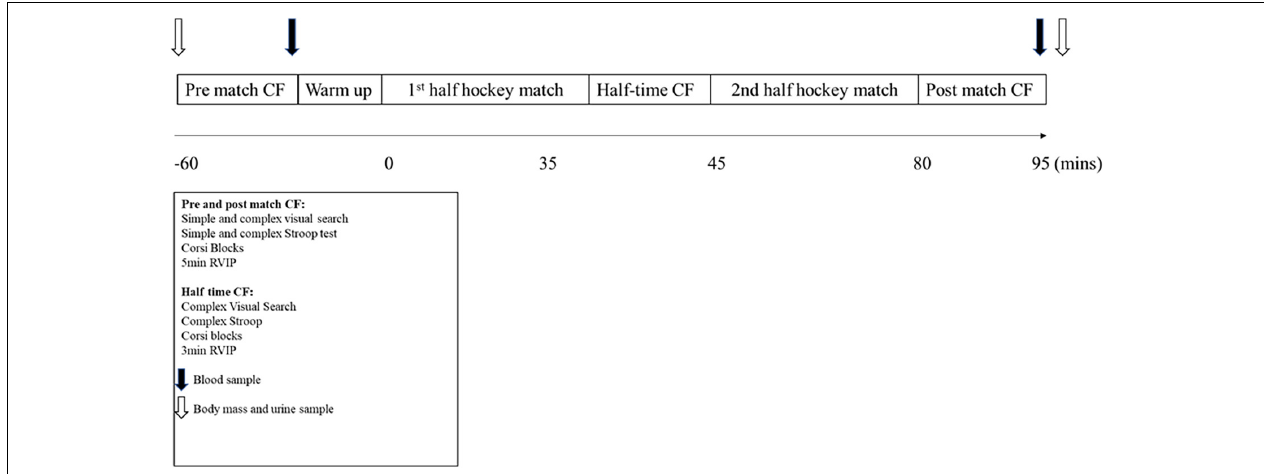
FIGURE 1 | Schematic of the match day protocol. CF, Cognitive function; RVIP, rapid visual information processing. Data is mean ±